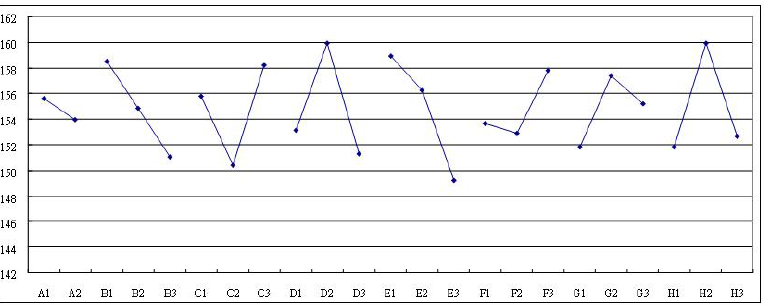
Figure 8. The gain cause effects graph of control